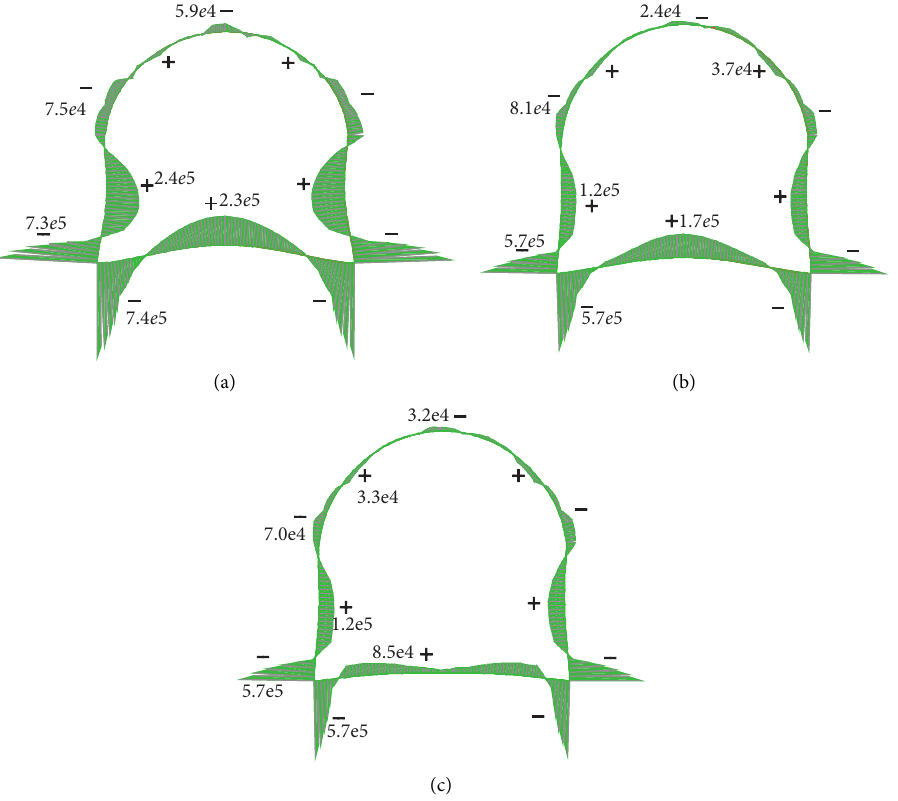
Figure 14: The moment distribution of surrounding rock (unit: Nm): (a) anchor net support; (b) anchor network cable is cooperatively supported; (c) after the high-pressure water jet roadway gang decompression on the basis of cooperative